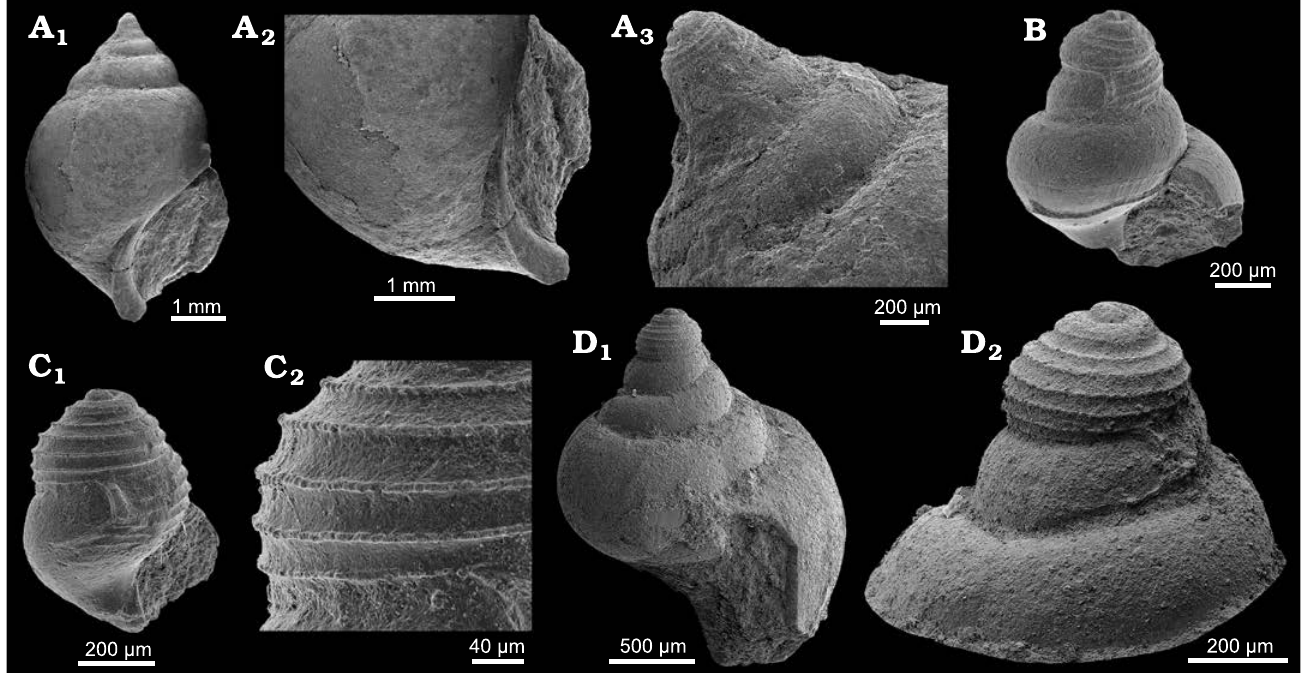
Fig. 14. Prostyliferid gastropods Prostylifer paludinaris (Münster, 1841) from Lago Antorno (A–C) and Misurina Landslide (D), northern Italy, Cassian Formation, Carnian, Upper Triassic. A . PZO 13680, relatively large specimen with preserved protoconch and inner lip, in apertural view (A 1 ); A 2 , close up showing umbilical chink and arched inner lip; A 3 , apex with mammilated protoconch having spiral crests, in lateral view. B . PZO 12823, juvenile specimen with protoconch having spiral crests, in apertural view. C . PZO 12824, juvenile specimen with protoconch having spiral crests; C 1 , larval shell ending at sinusigera, in apertural view; C 2 , close up of whorl of larval shell. D . PZO 12699, juvenile specimen with mammilated protoconch having spiral crests, in lateral view (D 1 ); D 2 , early whorls, larval shell ending at sinusigera, in lateral